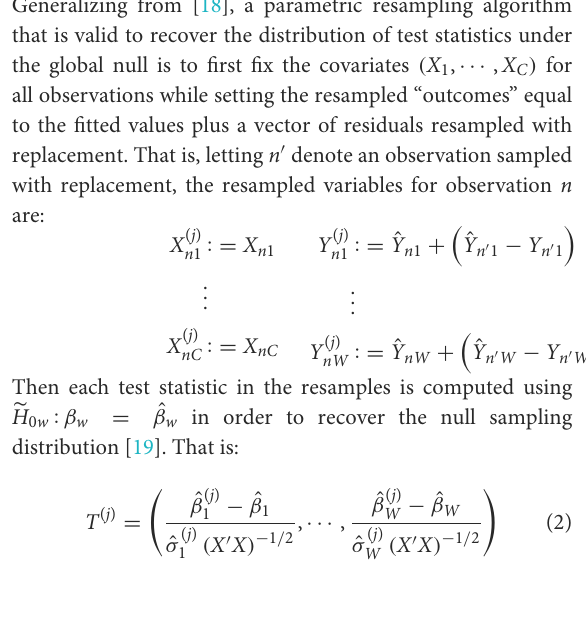
Algorithm 1. A valid resampling algorithm for